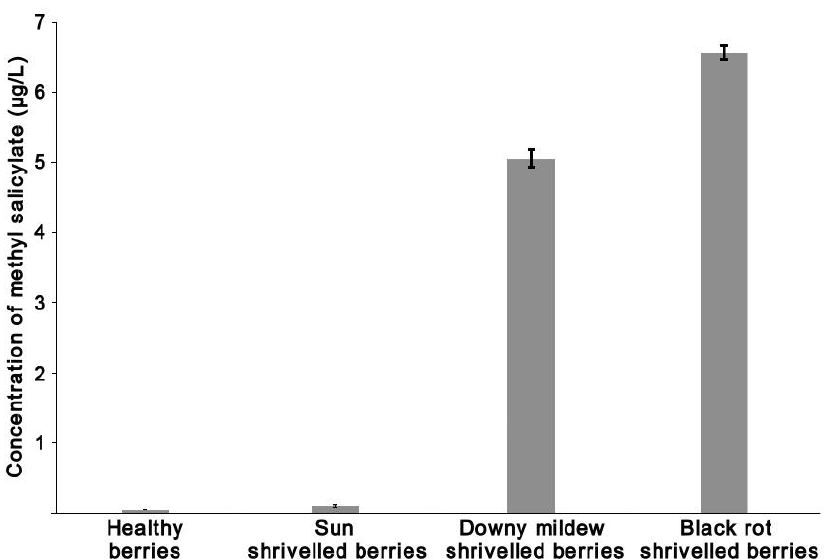
Figure 5. Concentration of methyl salicylate ( µ g/L) in fermented model must with Merlot berries: healthy control, sun-shrivelled berries and shrivelled berries affected by downy mildew and grape black rot [130]. Reprinted from Food Chemistry, 360, Poitou, X.; Redon, P.; Pons, A.; Bruez, E.; Delière, L.; Marchal, A.; Cholet, C.; Geny-Denis, L.; Darriet, P. Methyl Salicylate, a Grape and Wine Chemical Marker and Sensory Contributor in Wines Elaborated from Grapes Affected or Not by Cryptogamic Diseases, 130120, Copyright (2021), with permission from